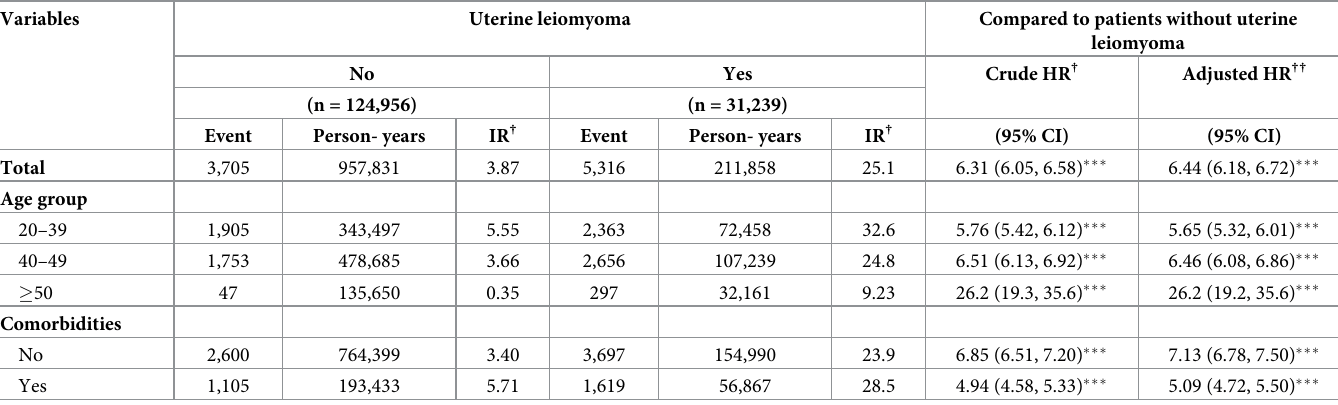
IR = incidence rates per 1,000 person-years; HR = hazard ratio; CI = confidence interval. † The crude HR represents the relative hazard ratio without adjustment for age and comorbidities. †† Variables found to be statistically significant in the univariable model were further examined in the multivariable model adjusted for age and comorbidities of tube- ovarian infection, endometritis, infertility, autoimmune diseases, allergic diseases, and breast cancer.